Question: In a single sentence, describe what this figure presents.
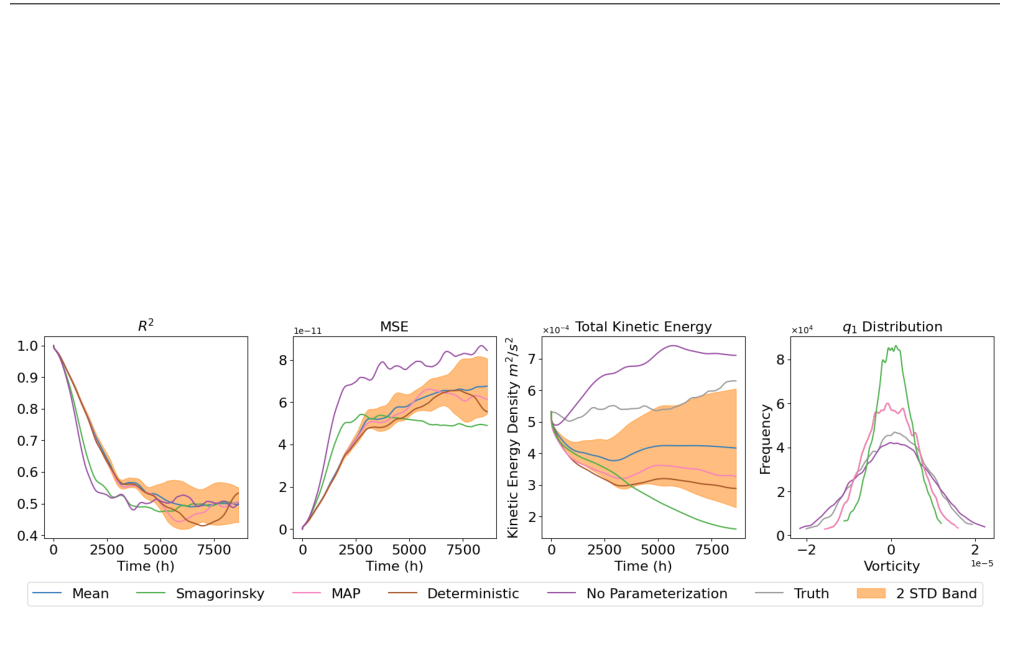
Answer: Metrics evaluating the performance of online predictions over 1 year period. Same as Figure 2, but evaluated on another test case.